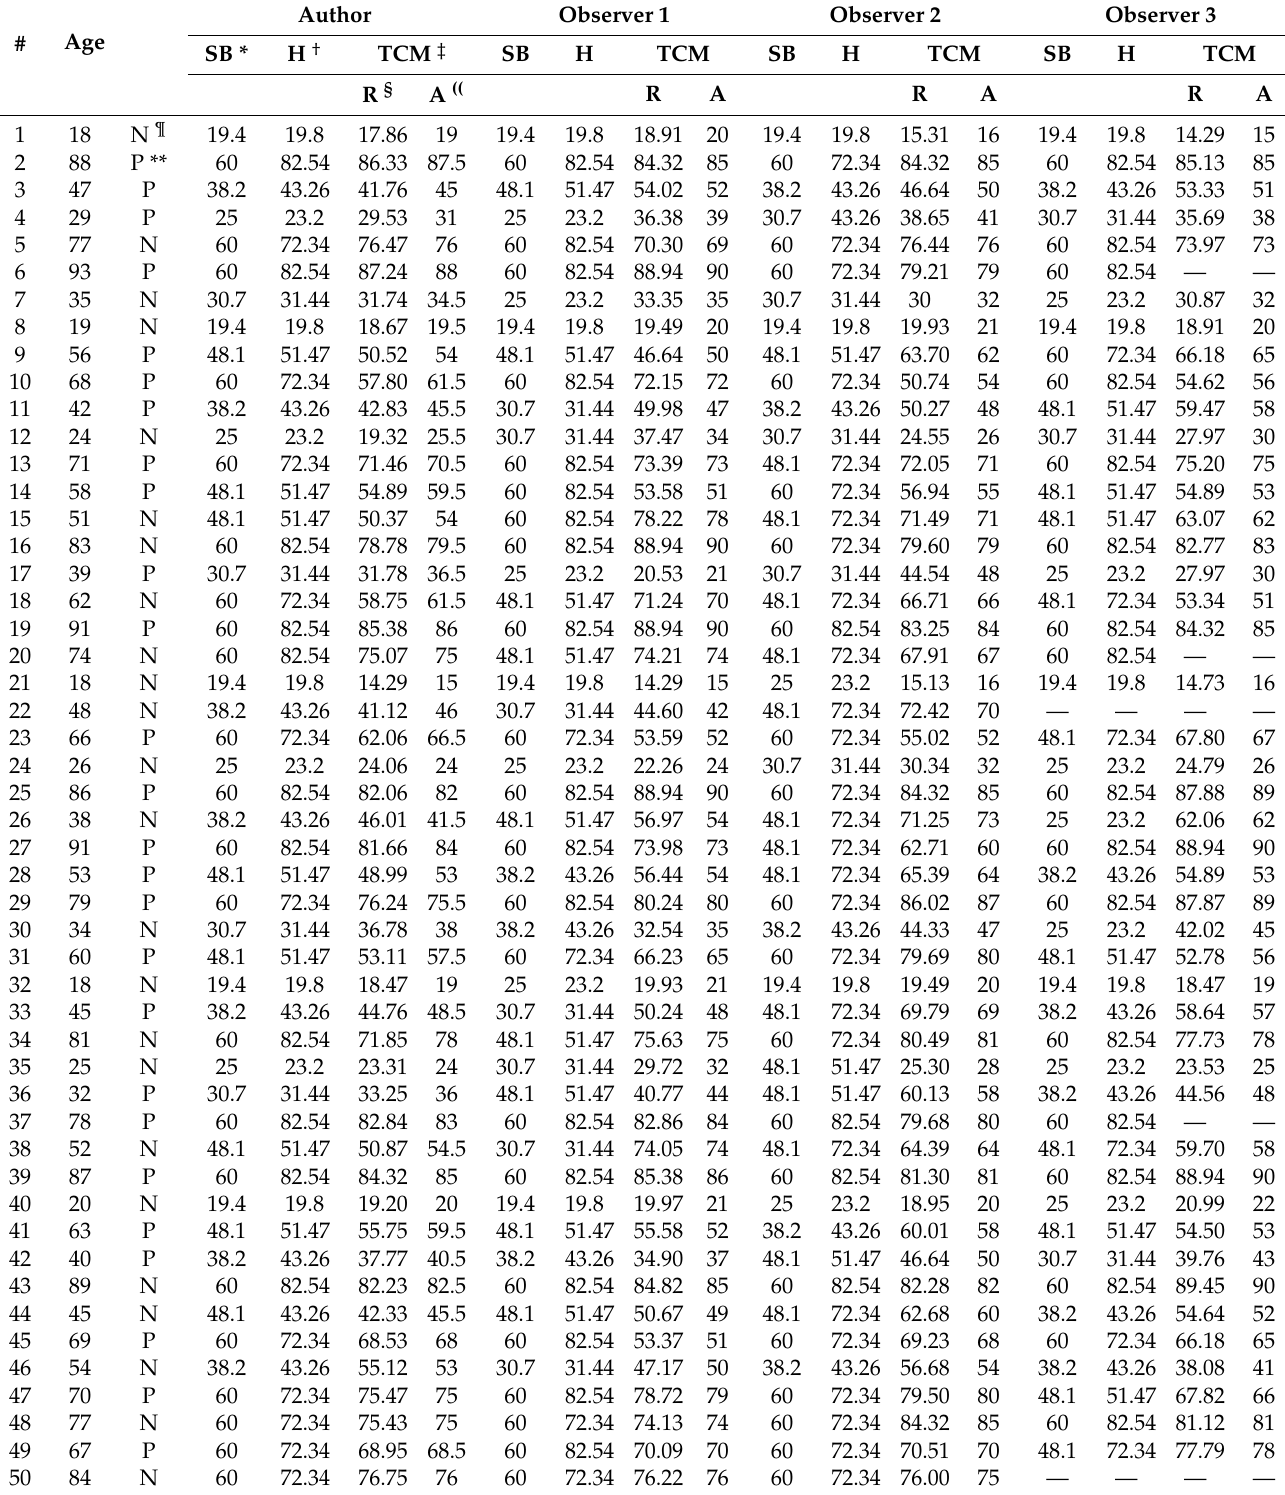
Table 7. Results by observer and method, observer subset ( n =